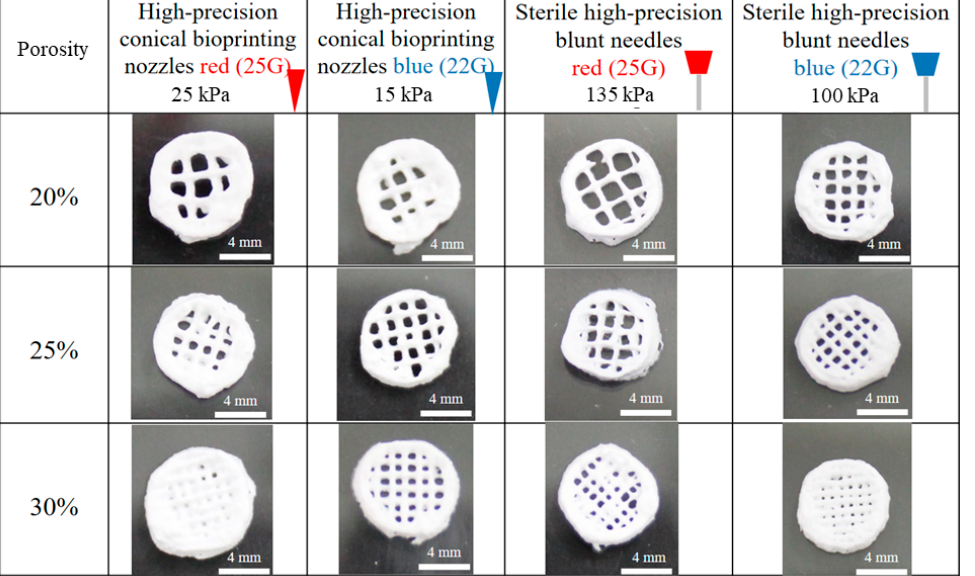
Figure 2. Optimization of 3D bioprinting parameters for obtaining porosity at 20%, 25%, and 30% using different needle densities (25G red plastic and metal, 22G blue plastic and metal) and different pressures (25, 15, 135, and 100